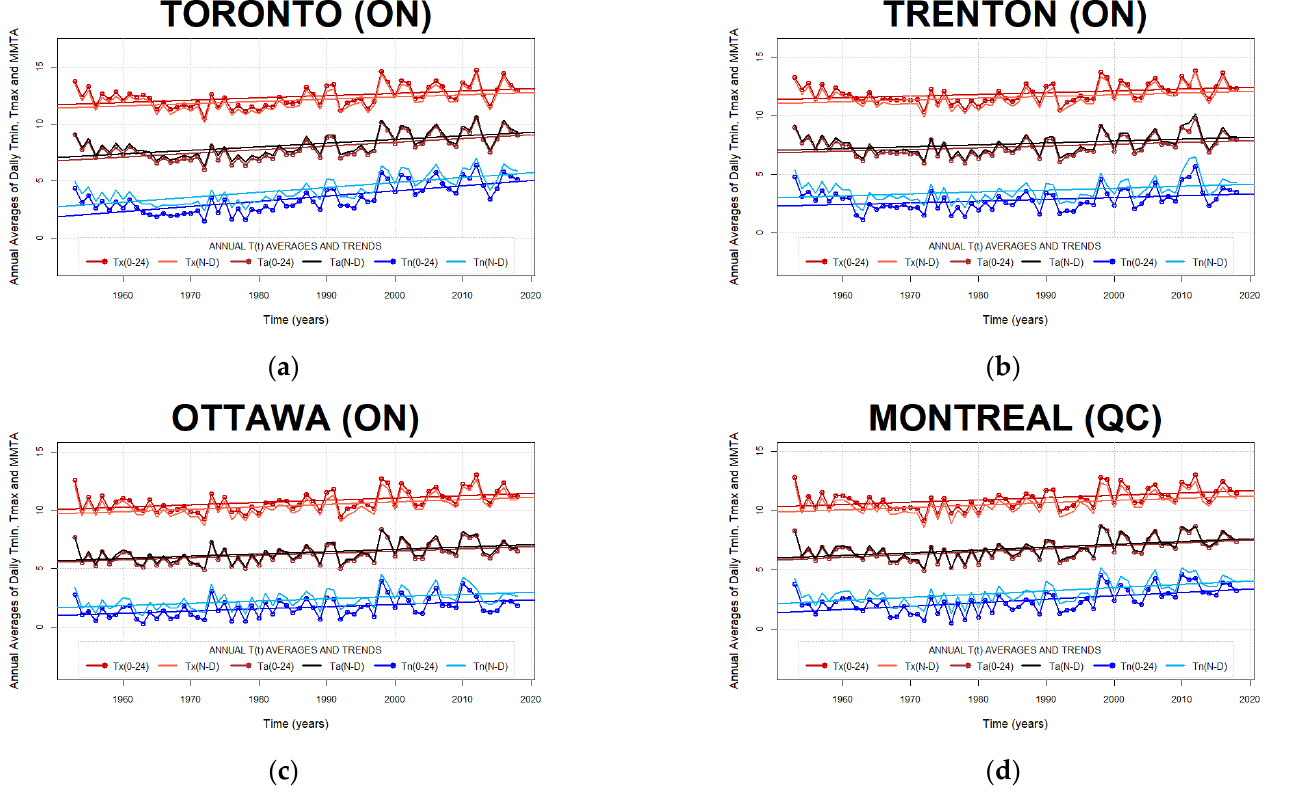
Figure 7. Effect of the observing window on long-term air temperature averaging for the Great Lakes/St. Lawrence Lowlands climate region at Toronto ( a ), Trenton ( b ), Ottawa ( c ), and Montreal ( d ) stations. Annually averaged diurnal air temperature minima, maxima, and Min-Max averages obtained with COW 0–24 and COW N–D air temperature approximating methods. On each graph, the blue lines represent annual averages of minima, the dark blue corresponding to COW 0–24 , and light blue to COW N–D minima. The red lines represent annual averages of maxima, the dark red corresponding to COW 0–24 , and light red to COW N–D maxima. Brown and black lines represent diurnal averages of extrema, or Min-Max averages, based on COW 0–24 and COW N–D extrema, respectively.